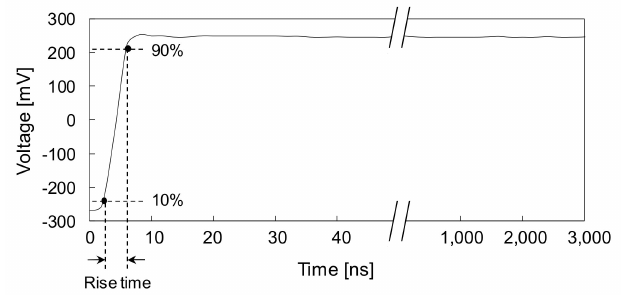
Figure 3. Step input signal generated by